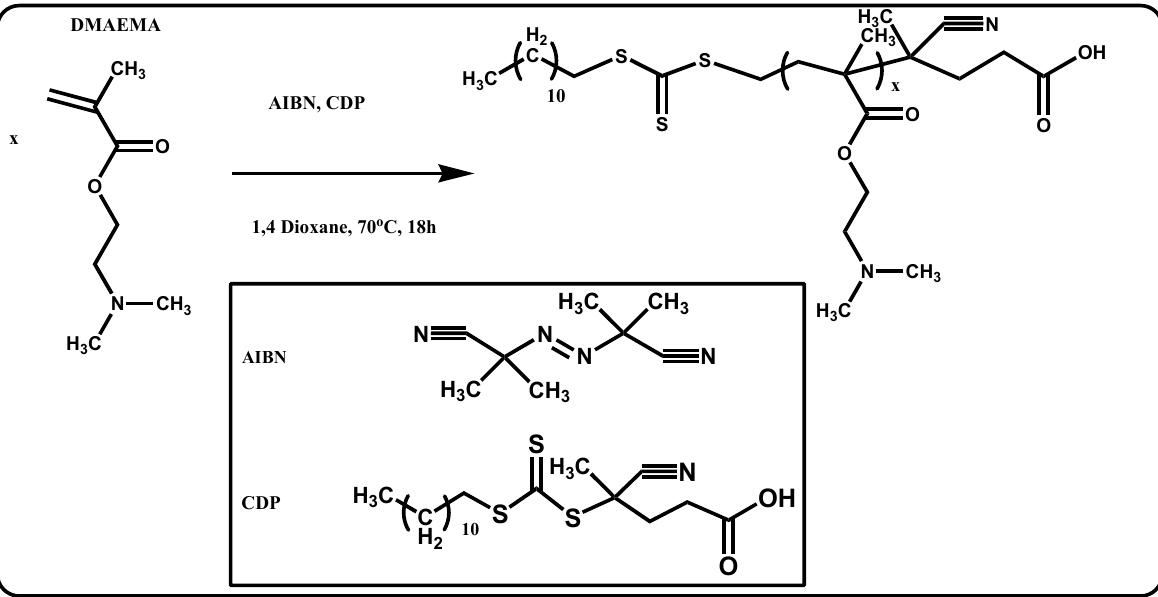
Table 1. Molecular characteristics of the PDMAEMA precursor and the quaternized PQFD am- phiphilic copolymers .